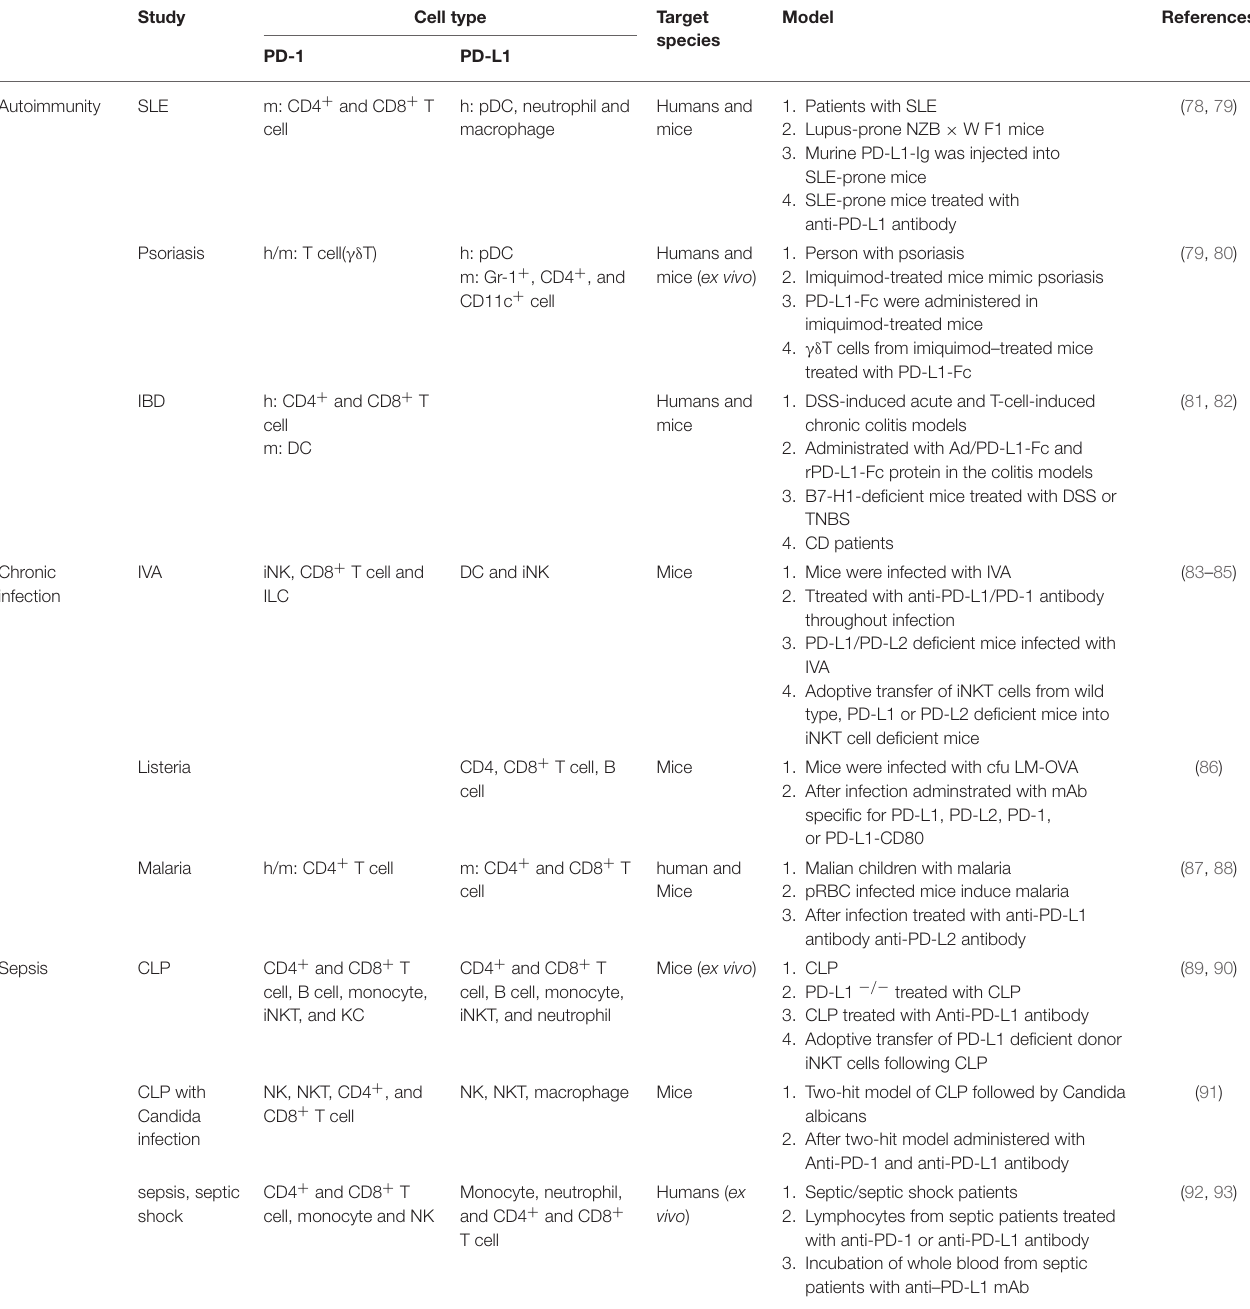
TABLE 1 | Summary of studies reporting PD-1/PD-L1 in autoimmunity and inflammatory